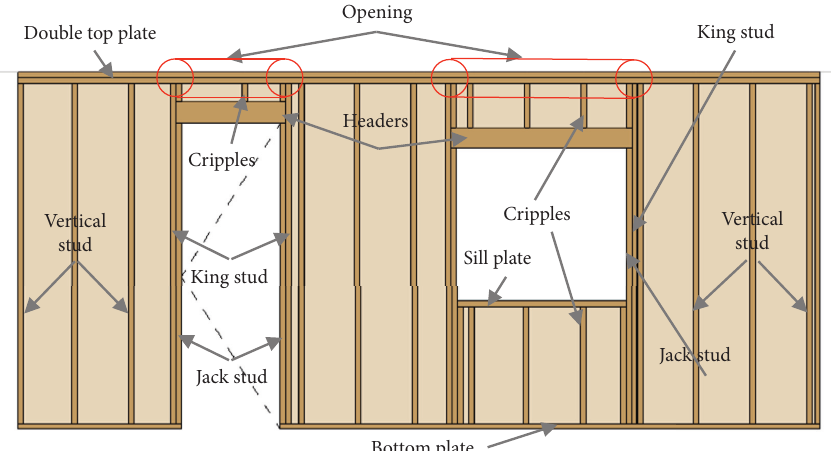
Figure 3: Wall frames with